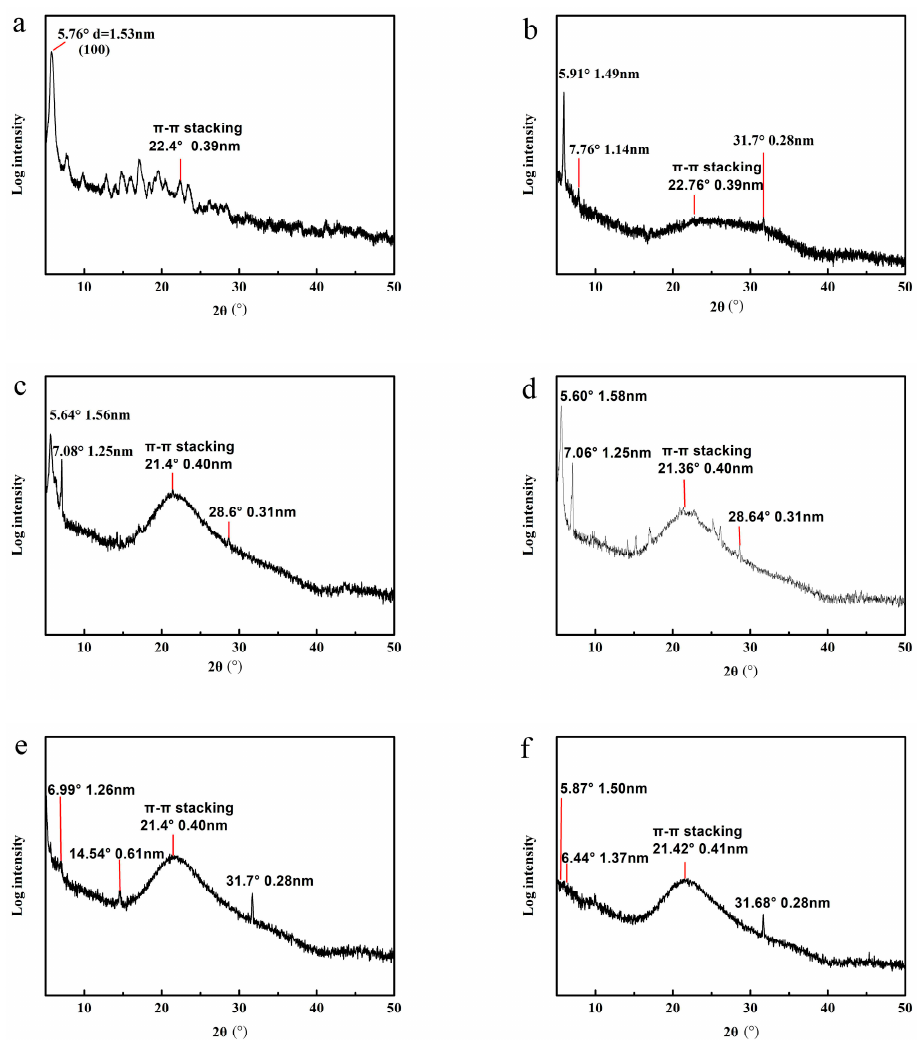
Figure 11. X-ray di ff raction (XRD) of PBI-1 powder and partial aggregates. ( a ) PBI-1 powder, ( b ) r = 0:1, ( c ) r = 30:1 p-toluenesulfonic acid, ( d ) r = 100:1 p-toluenesulfonic acid, ( e ) r = 200:1 formic acid and ( f ) r = 500:1 acetic acid.